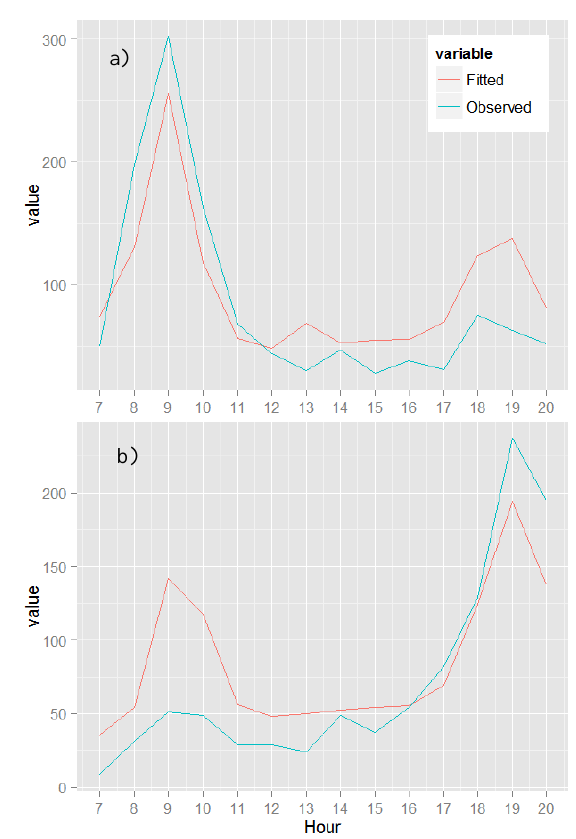
Figure 3. Example of model performance on a single link; a) inbound, and b)